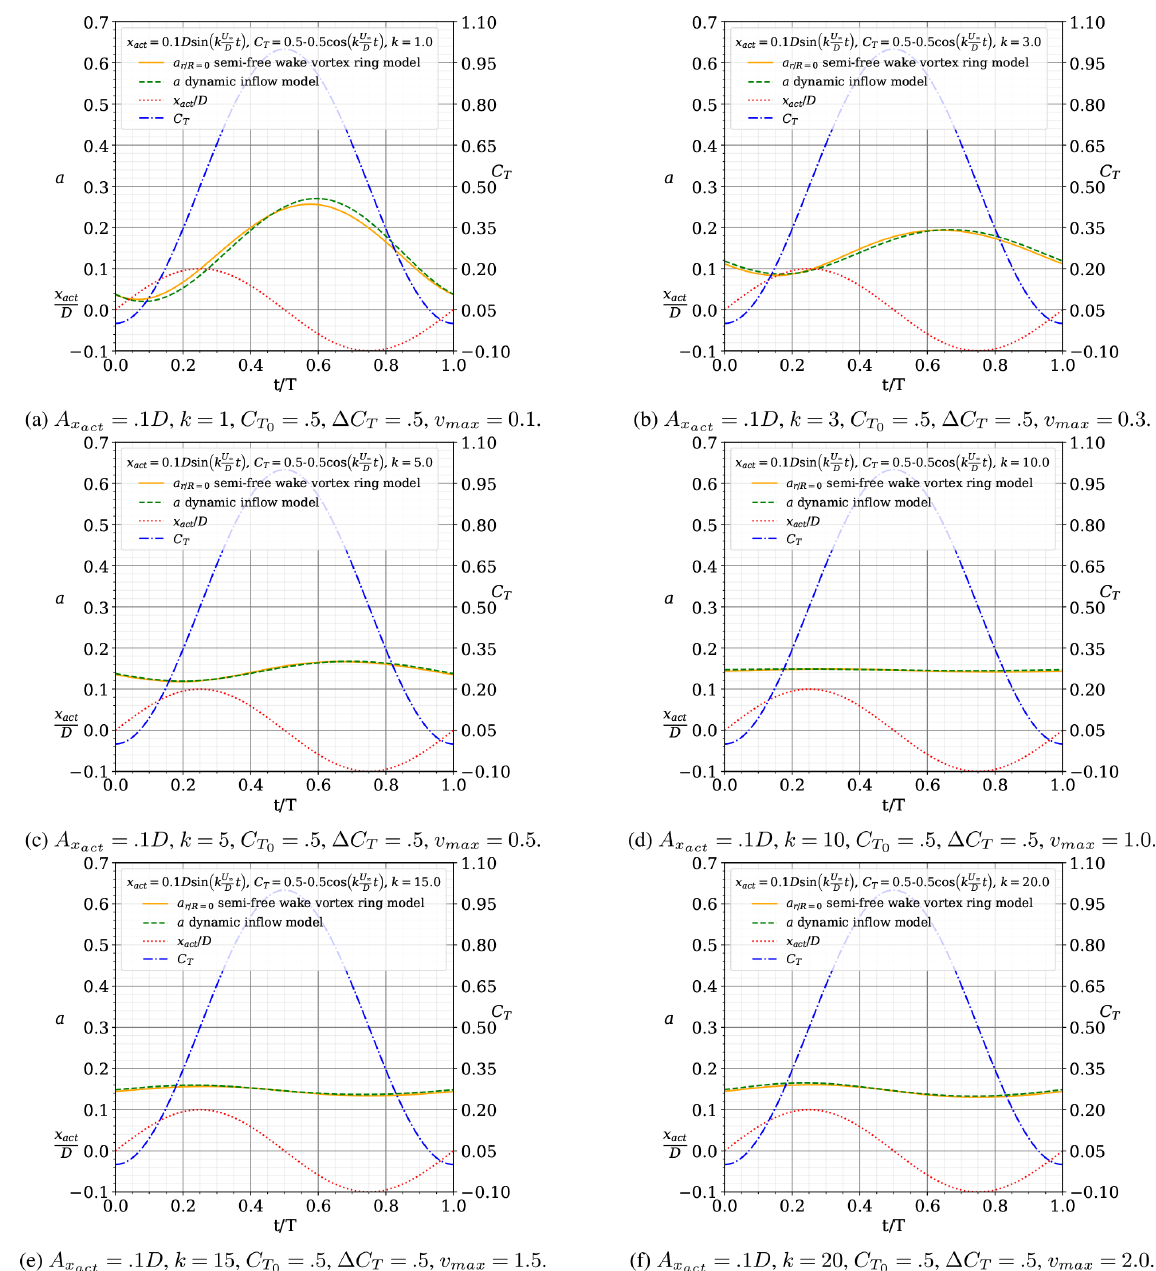
Figure 4. Comparison of the results of induction by the semi-free-wake vortex ring model and the proposed dynamic inflow model at the centre of the actuator r/R = 0 for a sinusoidal surge motion with x act = A x (cid:49)C T cos ( kU ∞ /Dt ) (also plotted). The results are plotted over one period, along the non-dimensional time t/T . Cases with different re- duced